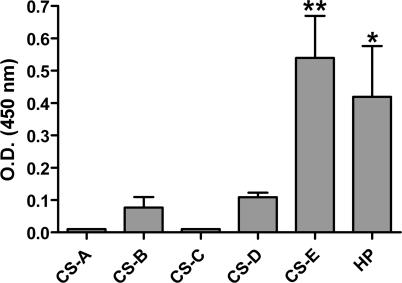
Direct Binding of DENV NS1 with HS and CS-EMicrotiter plates were coated with indicated soluble GAG overnight at 4 °C. After incubation with supernatants from BHK-DENV-2-Rep cells or control BHK cells, bound DENV NS1 was detected using DENV NS1–specific mAbs, followed by biotin-conjugated anti-mouse IgG and HRP-conjugated streptavidin. Plates were read at an optical density of 450 nm on a 96-well plate reader. Data are the mean ± SD from four independent experiments. Asterisks denote NS1 binding that is statistically different from binding to background (* p < 0.05, ** p < 0.005). O. D., optical density.